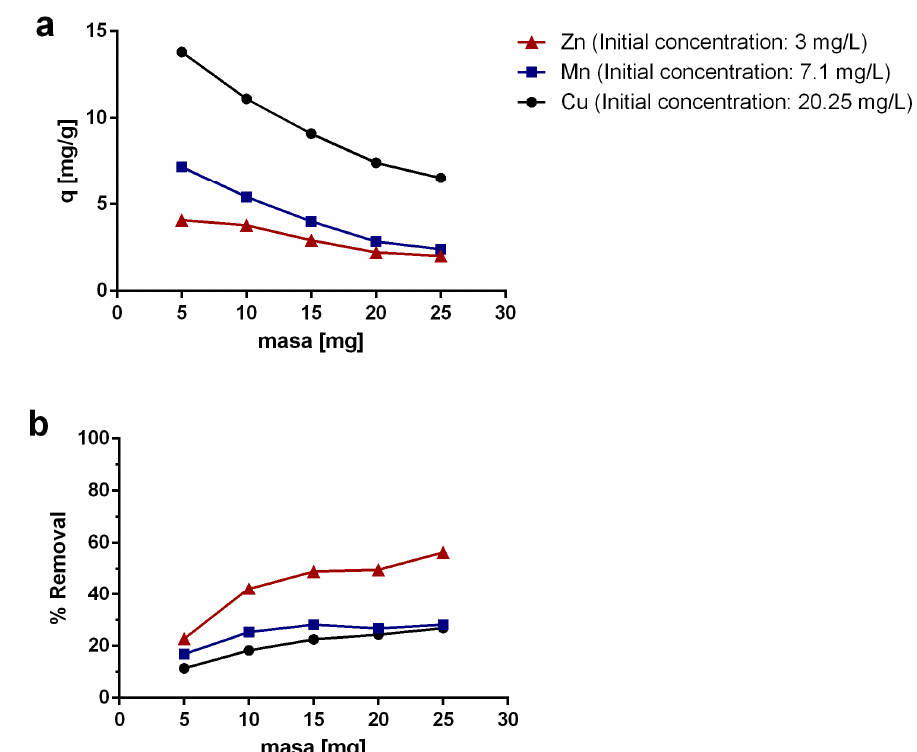
Figure 4. ( a ) Sorption capacity (q) [mg / g] and ( b ) removal rate of Cu, Mn, and Zn. Experiments were carried out using a constant adsorbate concentration and a variable mass of oxidized MWCNTs as sorbent material.